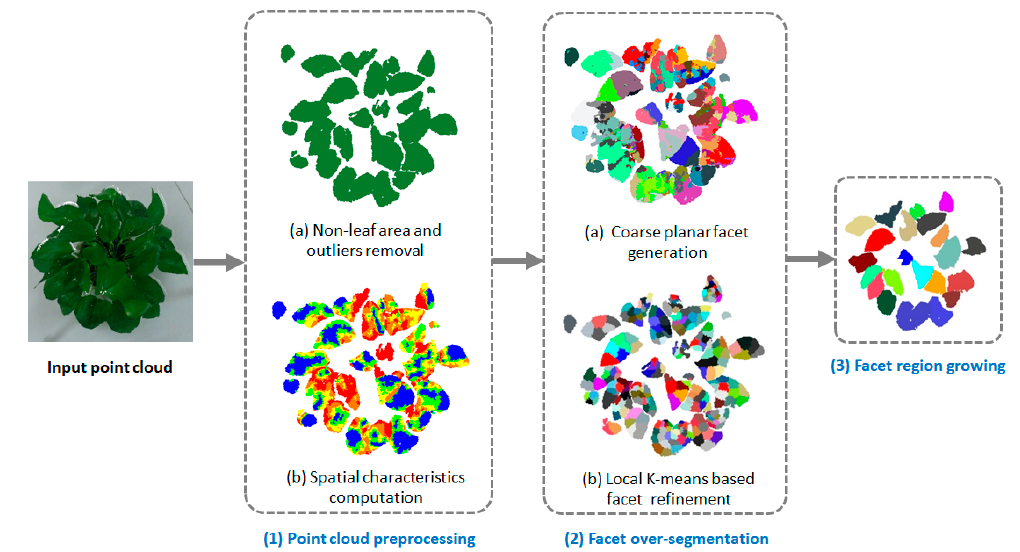
Figure 2. Overview of the proposed method.